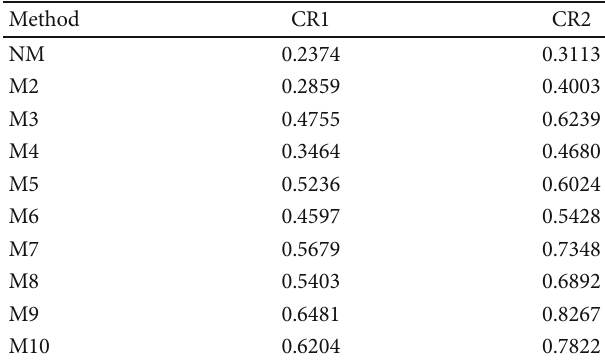
Table 15: Values of CR1 and CR2 for methods 1-10 to solve Test Problem 5, by the algorithms of the fi rst category for n = 100